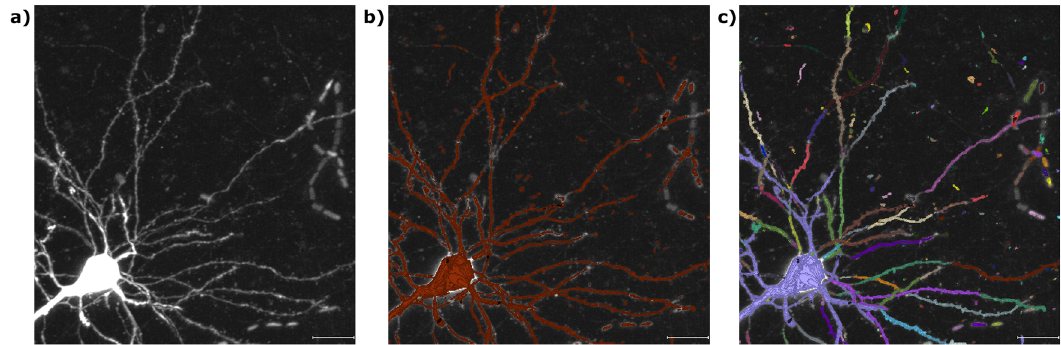
Fig. 1 Image segmentation models sever neuronal processes. a An image subvolume from the MouseLight project containing a single neuron. b The same image overlaid with a binary image mask in brown. This mask was generated by the random forest based software Ilastik 32 and illustrates the typical output of an image segmentation model. c The same binary image mask, with a different color for each connected component. The variety of colors shows that the neuron has been severed into several pieces. All panels are maximum intensity projections (MIPs), and the scale bar represents 15